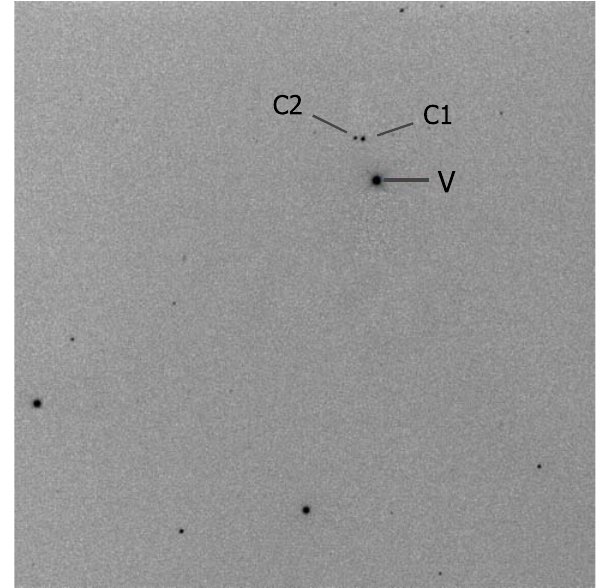
Fig. 2 One of the CCD images of IK Boo (V), obtained using the 74 inch Telescope of the Kottamia observatory in Egypt. C 1& C 2 are the comparison and check stars, respectively. North is up and East is to the left.